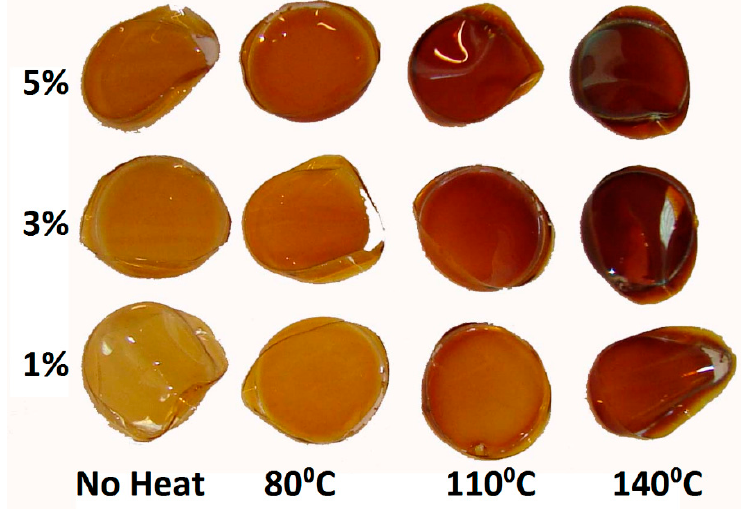
Figure 2. Silver cross-linked PVA films containing 1%, 3% or 5% w/w silver nitrate, dried at 60 °C overnight and then heat cured at various temperatures for 90 min.